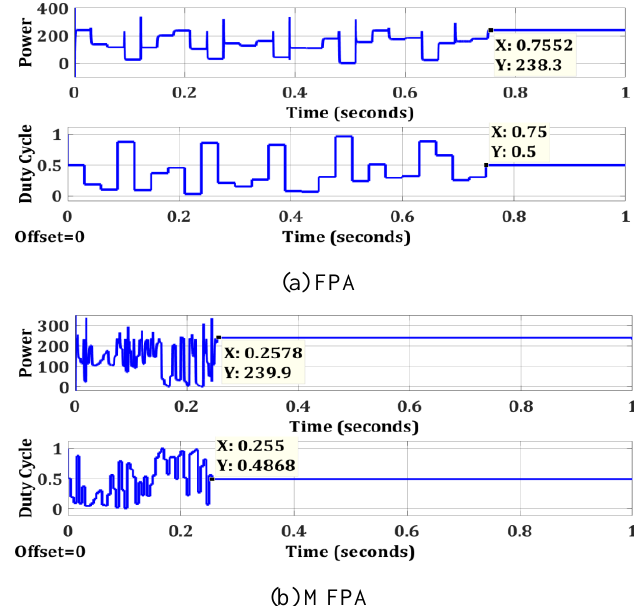
Fig. 9. Performance Assessment of (a) FPA and (b) MFPA under Zero Shading/UWC